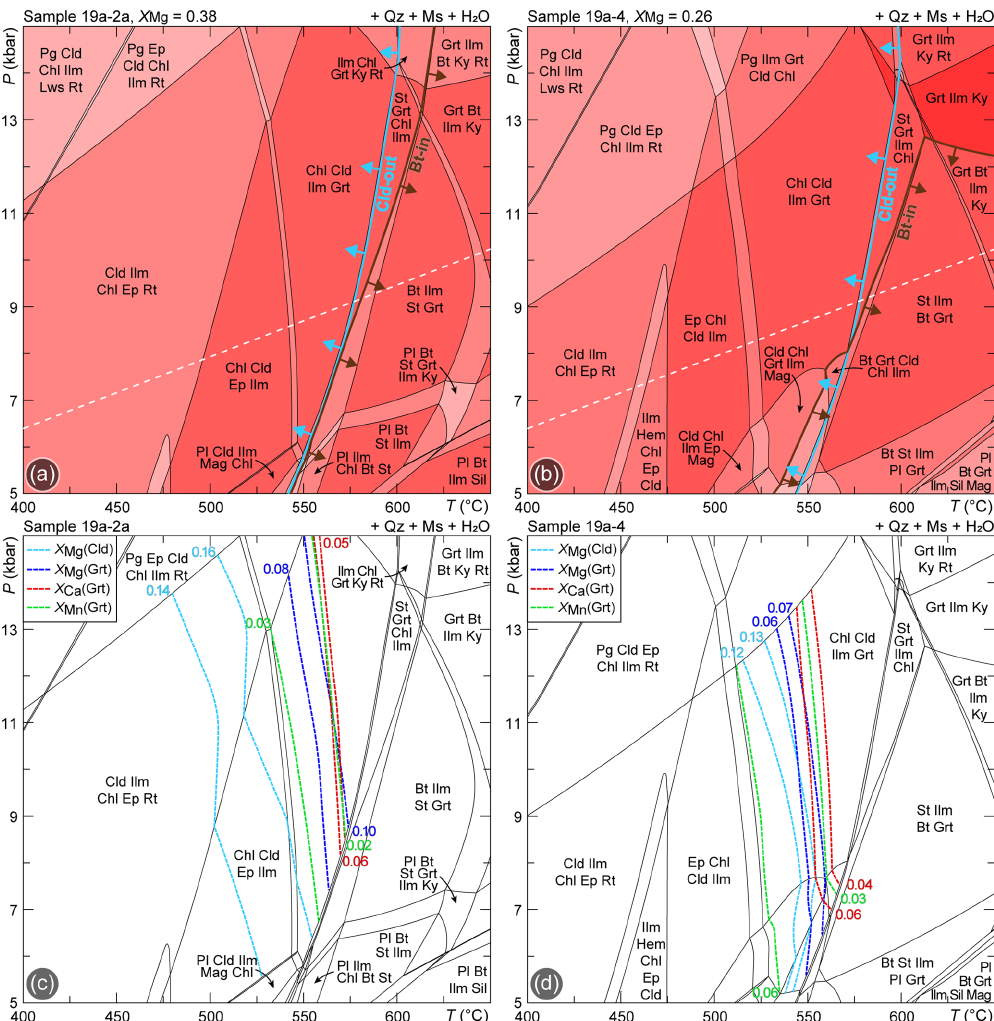
Figure 6. P – T isochemical phase diagrams modelled for (a) sample 19a-2a and (b) sample 19a-4, using the bulk compositions reported in Table 1. The chloritoid-out and the biotite-in reaction curves are highlighted in light blue and brown, respectively. The dashed white line indicates the thermobaric gradient used in the following phase diagrams. Compositional isopleths for chloritoid and garnet have been plotted for (c) sample 19a-2a and (d) sample